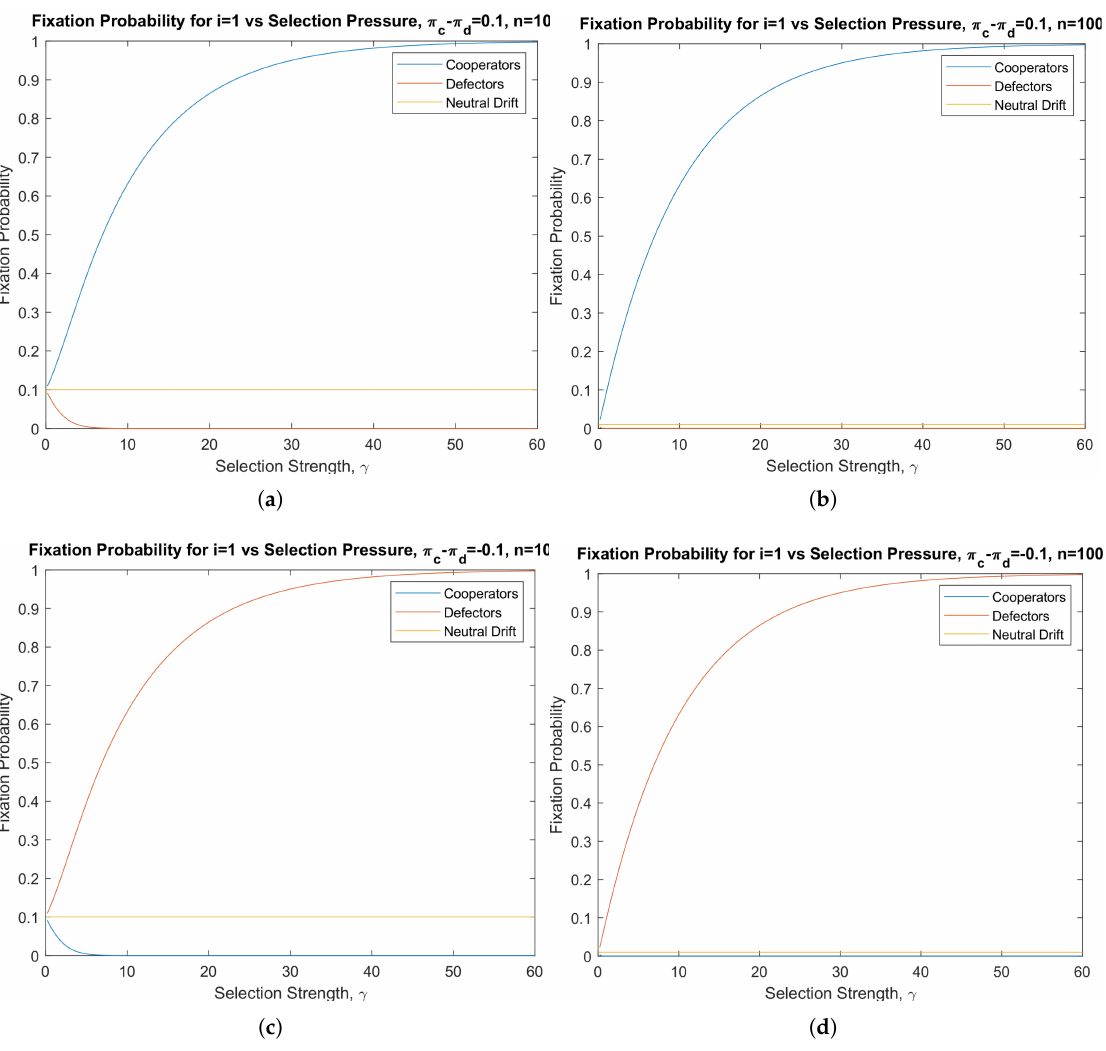
Figure 2. Pairwise invasion dynamics in finite populations. Shown are the graphs of fixation probabilities for π c − π d > 0, as in panels ( a , b ), and for π c − π d < 0, as in panels ( c , d ). If π c − π d > 0, the fixation probability starting with one cooperator x 1 is always larger 1/ n (neutral drift) which is in turn always larger than that of one defector, y 1 . On the other hand, if π c − π d < 0, then the situation is reversed, that is, y 1 > 1/ n > x 1 . We confirm that the specific values chosen for π c − π d are admissible for the given values of population size n